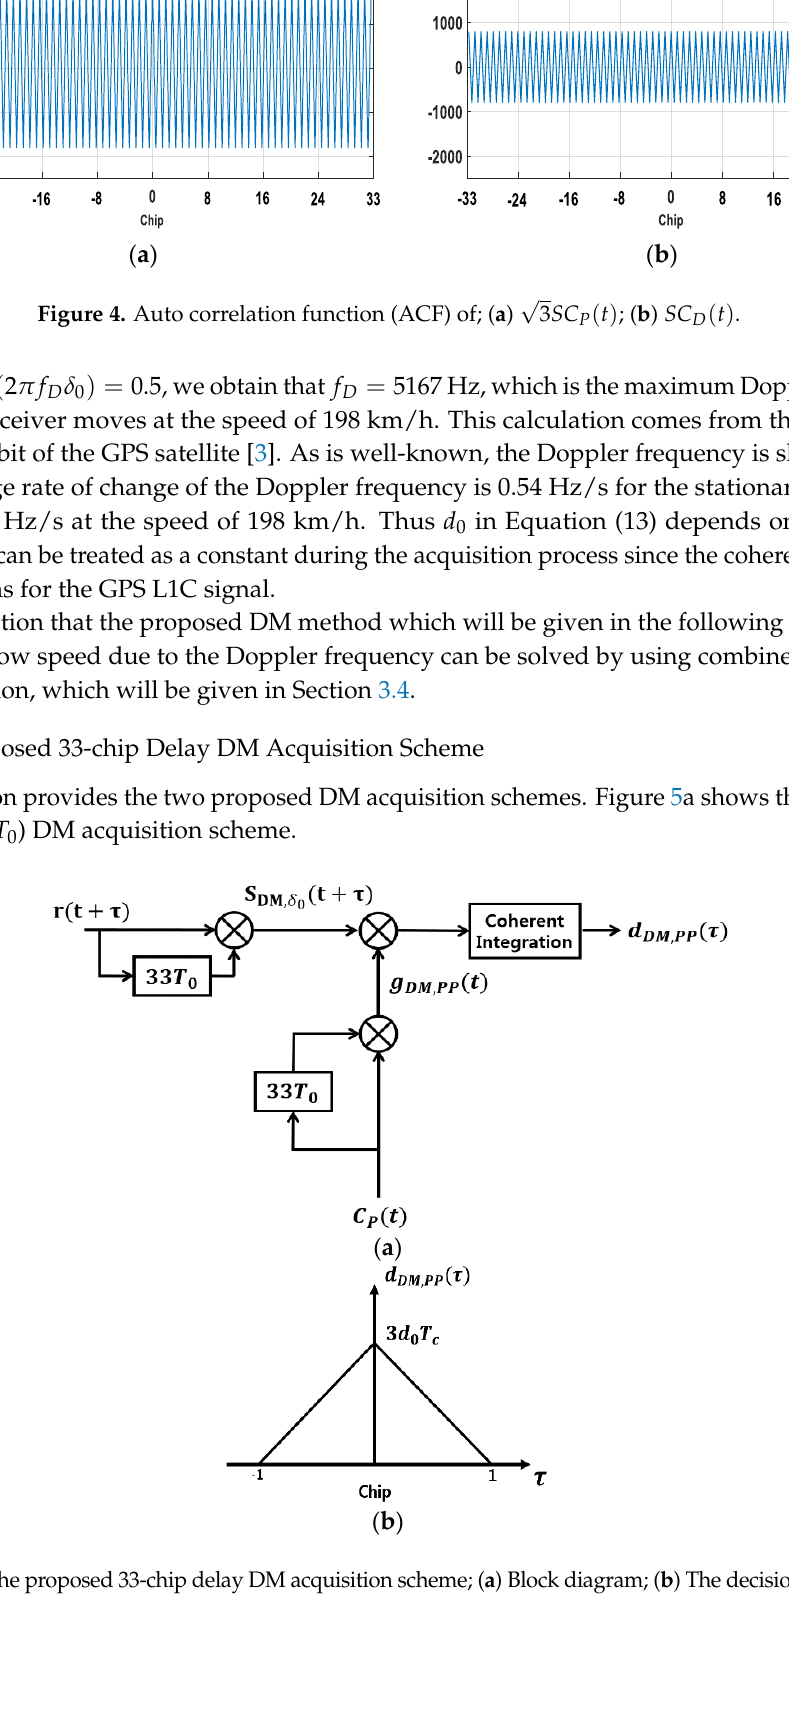
Figure 4. Auto correlation function (ACF) of; ( a ) √3𝑆𝐶 𝑃 (𝑡); ( b ) 𝑆𝐶 𝐷 (𝑡) .